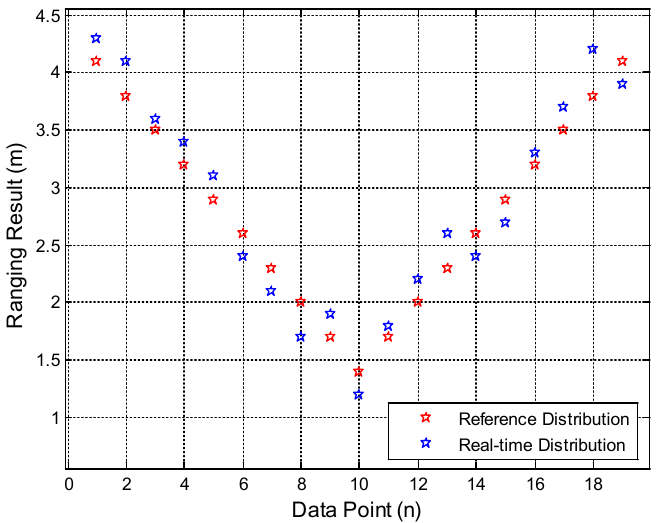
Figure 9. Comparison between reference distribution and real-time distribution.